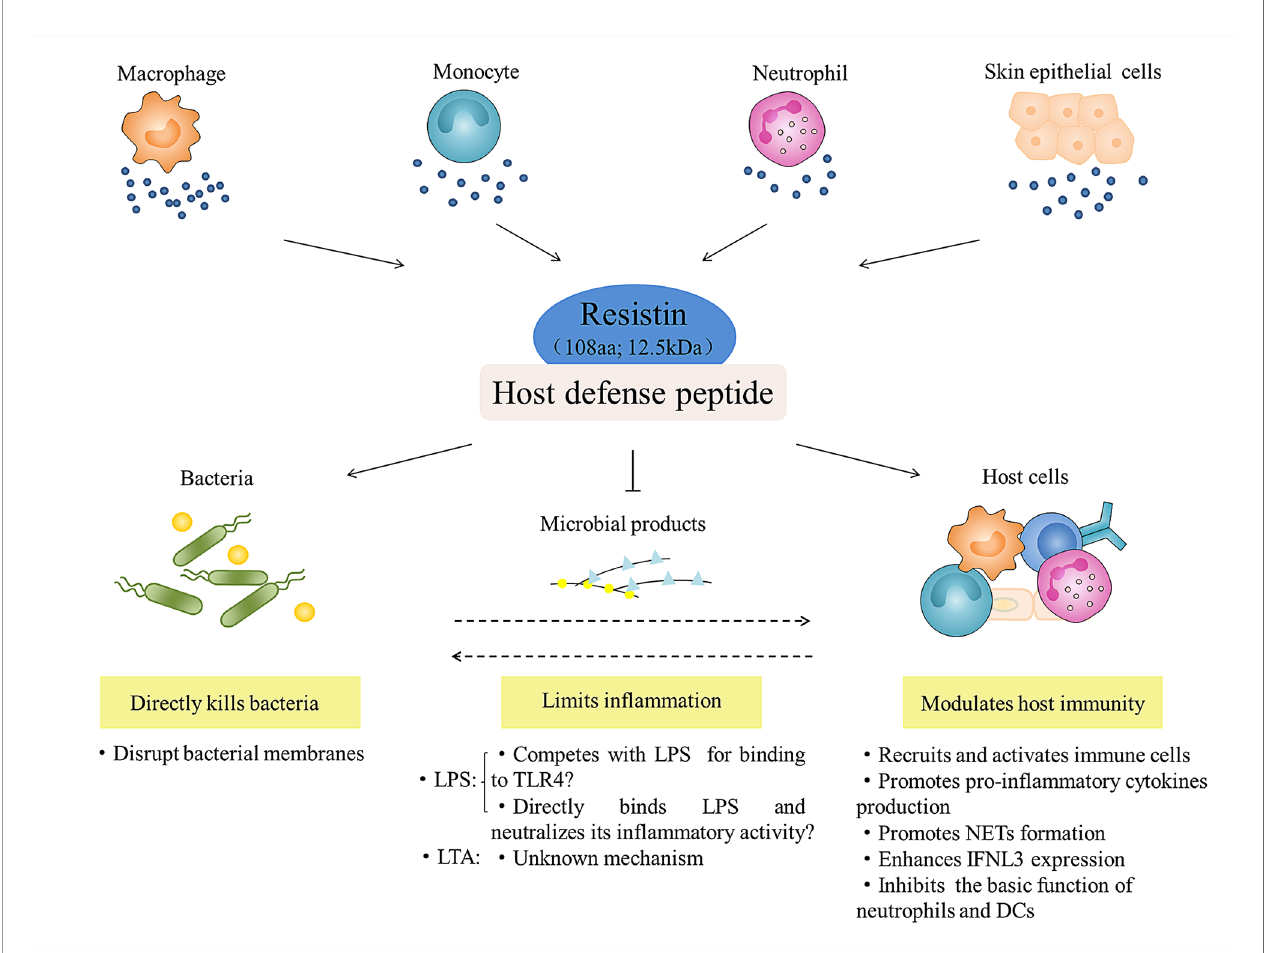
FIGURE 5 | Role of resistin in host defense. Leukocytes (i.e., macrophage, monocyte, and neutrophil) and skin epithelial cells-derived resistin act as host defense peptide, and participate in the innate anti-infection immunity of the host at least three ways: they directly kill bacteria; they regulate and balance the in fl ammatory response to microbial products (LPS and LTA); and they activate and amplify the host immune response to indirectly resist microbial